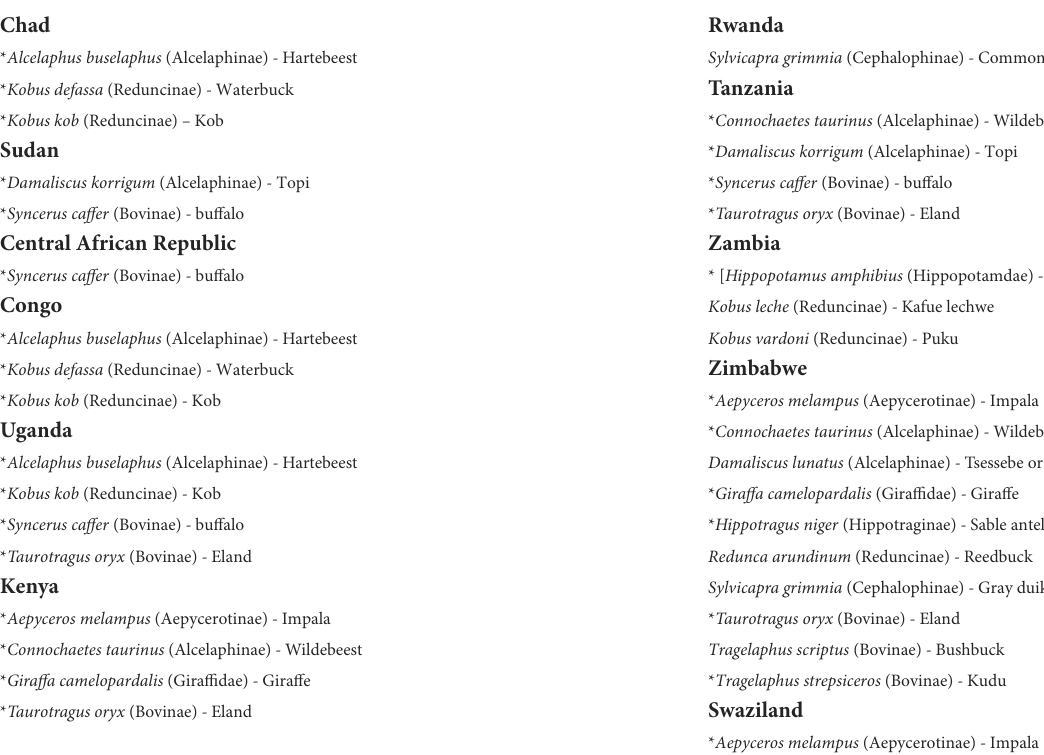
TABLE 8 Species of the wild fauna of Africa in which infection by Fasciola gigantica has been